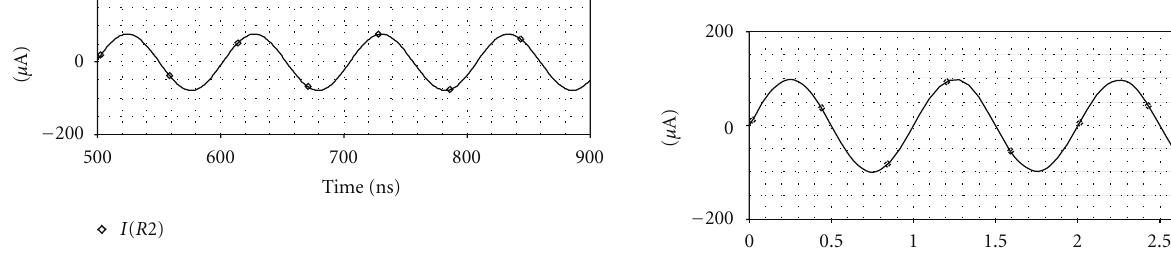
Figure 6: Low pass output for sinusoidal input of 9.7 MHz.